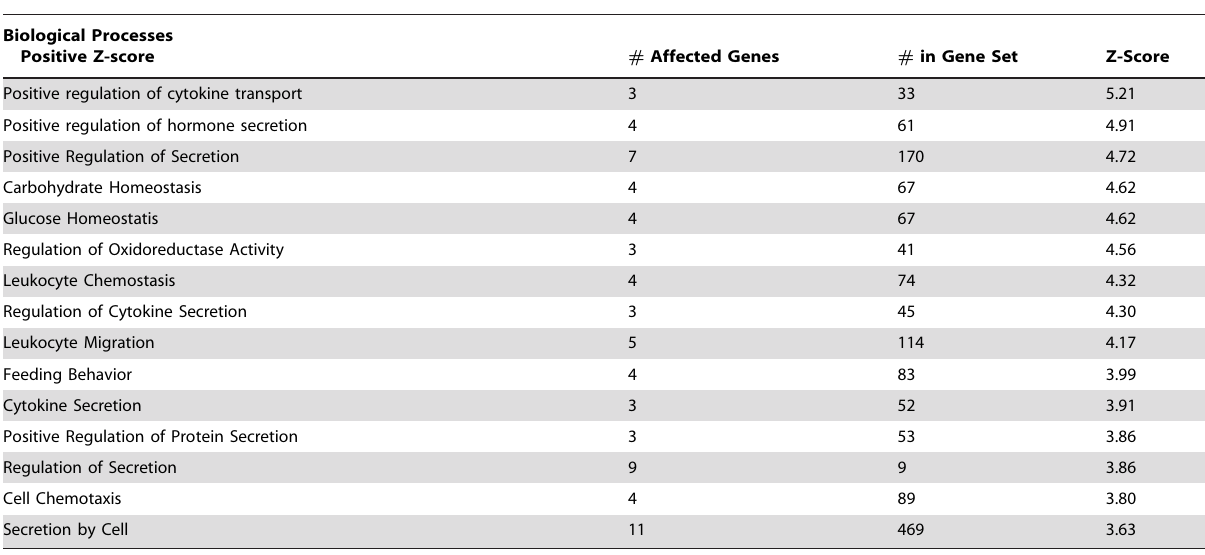
Table 2. Changes in Brain Expression with CCI and mHW: Biological Processes.